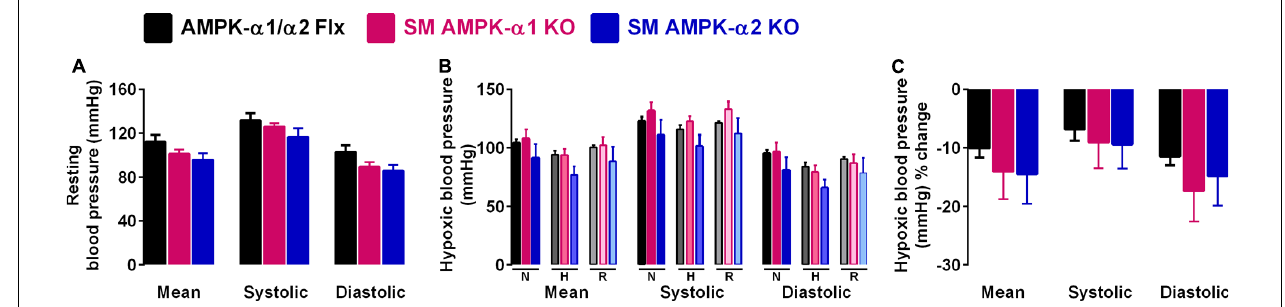
FIGURE 3 | Deletion of AMPK- α 1 and AMPK- α 2 subunits in smooth muscles has no effect on systemic arterial blood pressure during normoxia or hypoxia. (A) Bar charts show (mean ± SEM) the mean, systolic and diastolic blood pressure of control mice [AMPK- α 1/ α 2 floxed (Flx); n = 4; black] and mice with AMPK- α 1 ( n = 4; magenta) and AMPK- α 2 ( n = 4; blue) deletion in smooth muscles (transgelin expressing cells). (B) Bar charts show the same measures of blood pressure during normoxia (N), after 10 min to hypoxia (H; 8% O 2 ) and following recovery to normoxia (R). (C) Bar charts show the percentage change in blood pressure during hypoxia.